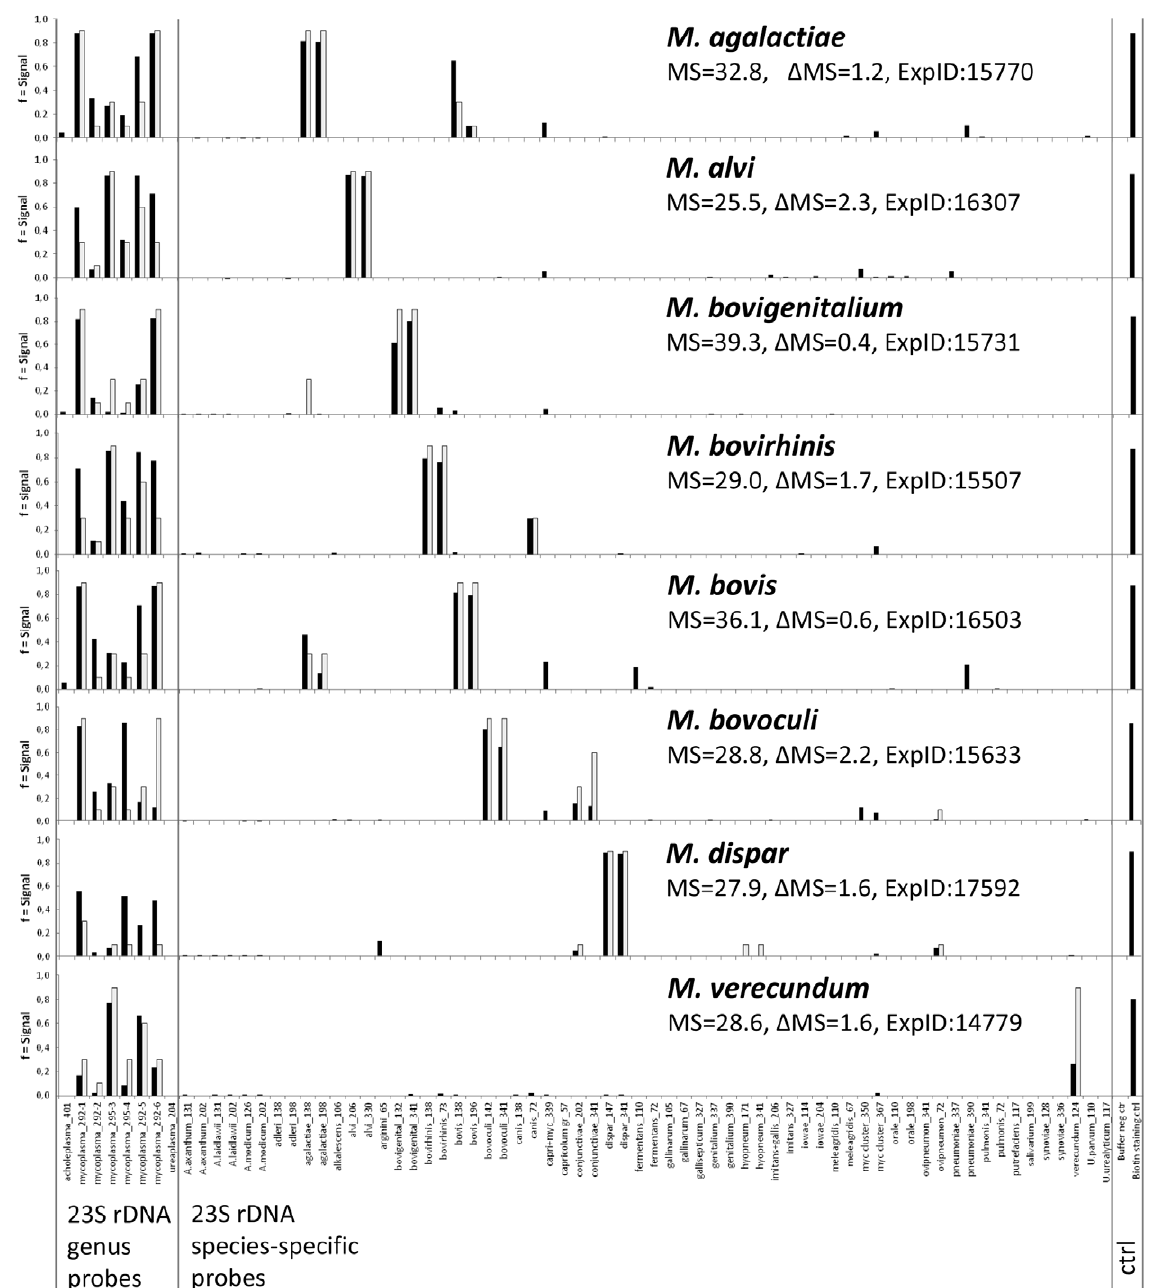
Figure 2. Differentiation based on 23S rDNA probes among eight Mycoplasma species potentially occurring in cattle. Black bars denote experimental signals, gray bars denote theoretically predicted signals. Each hybridization experiment is characterized by matching score (MS) and accuracy (Delta MS, see Materials and Methods). Control bars at the right-hand margin show spotting buffer (background control) and biotinylated oligonucleotide (staining